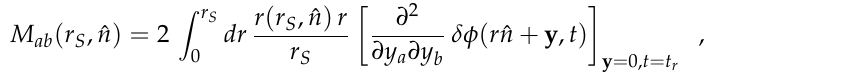
Figure 7. Comparison of the numerical prediction of the classical Λ CDM program vs. the numerical prediction of the RG running of Newton’s constant’s effect on the B-mode (BB) power spectrum C BB The solid curves represent the numerical predictions generated by ISiTGR, with the top (blue) and bottom (green) representing c 0 = 0,1.146 respectively, showing no significant deviation with the classical no running numerical Λ CDM curve. The dashed curve represents error-weighted quadratic fit for observational CMB data from the Planck (2018) collaboration [13]. The other c 0 = 8.02 curve, like the c 0 = 8.02 (green) curve, is consistent with zero (to around 1 part in 10,000). So any deviations from the classical and c 0 = 1.146 curve are too insignificant to be seen, and negligible relative to the size of the error bars from the current latest data. Hence the c 0 = 8.02 curve is not included in this plot for